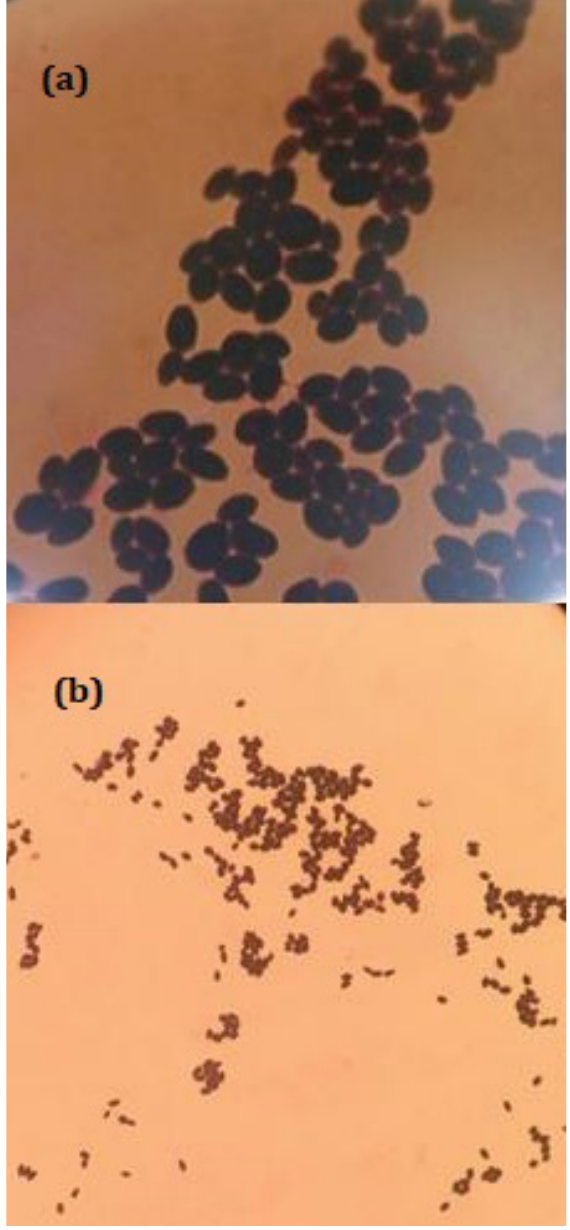
Figure 2. (a, b): Single cell and budding stages of Saccharomyces cerevisiae after gram